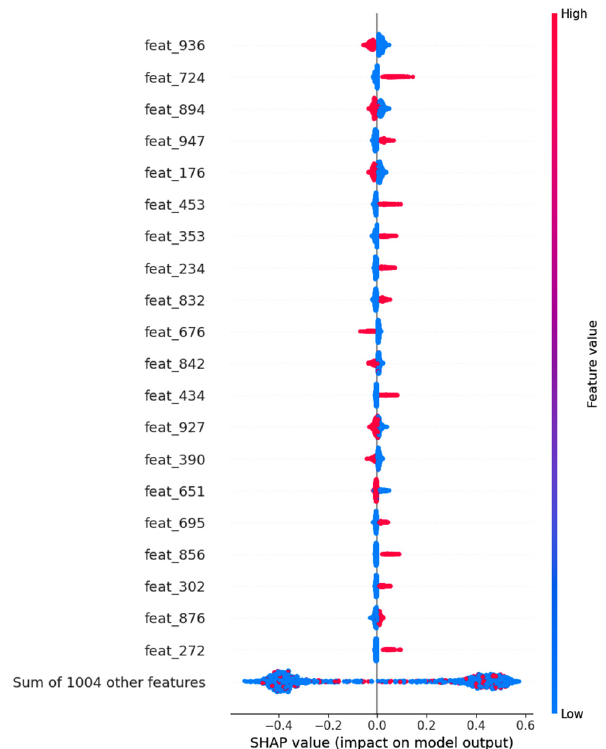
Figure6: GlobalfeatureimportancefortheECFP4model trained on the NCI 1 dataset. Only the 20 most important features are shown, and features are ordered according to their importance. Each point represents a sample in the test set, and the color of the points represents the value of a particular feature for that